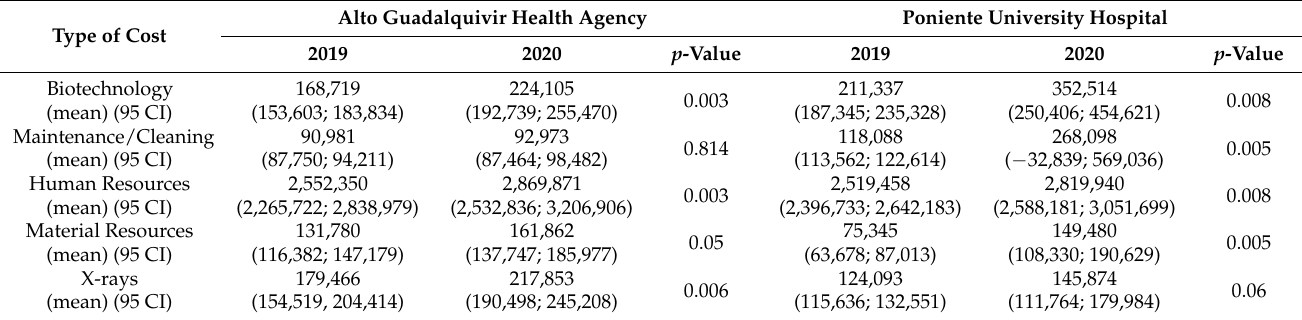
Table 3. Descriptive statistics of costs by type of mean cost and year for both periods.